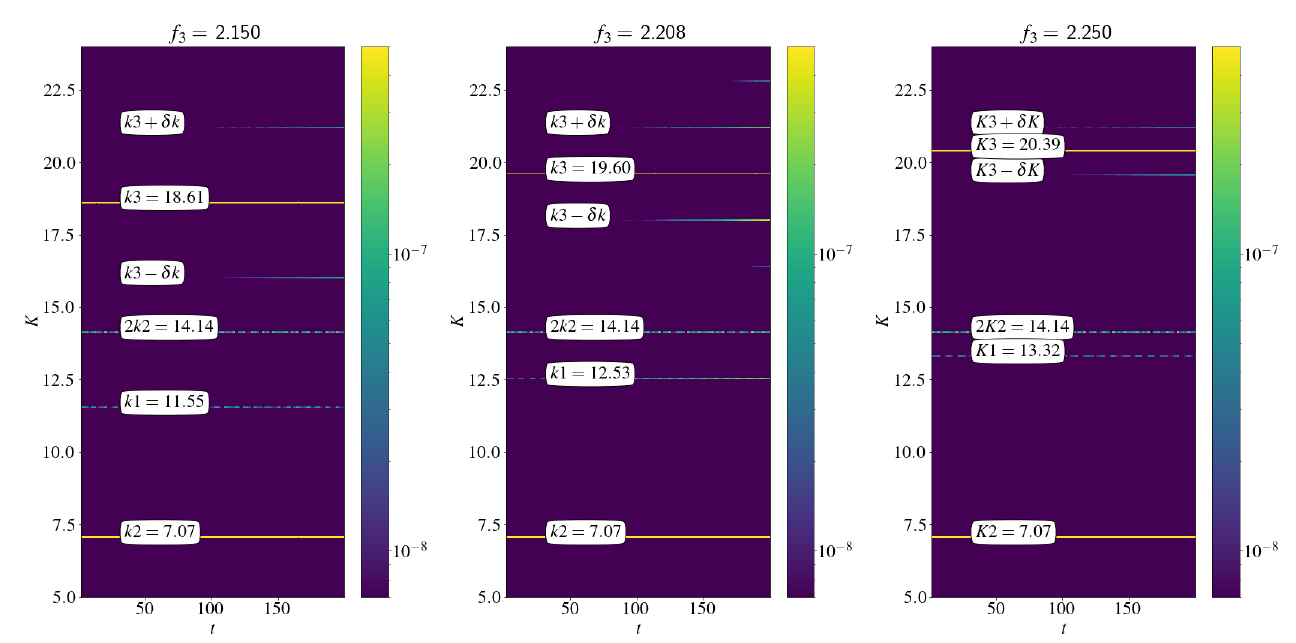
Figure 4. Time dependent spatial Fourier spectra, | a K ( t ) | , with the pertinent modes annotated, as in Figure 3 an increase of energy transfer is observed in K 1 at the resonant frequency ( f 3 / Hz ≈ 2.206, K 3 = 1248 2 π ) compared to off resonance L ( f 3 / Hz = 2.25, K 3 = 1298 2 π and f 3 / Hz = 2.15, K 3 = 1185 2 π ). The decrease in K 3 can be attributed to side-band L L instability, present in all cases, but not impeding the five-wave resonance.